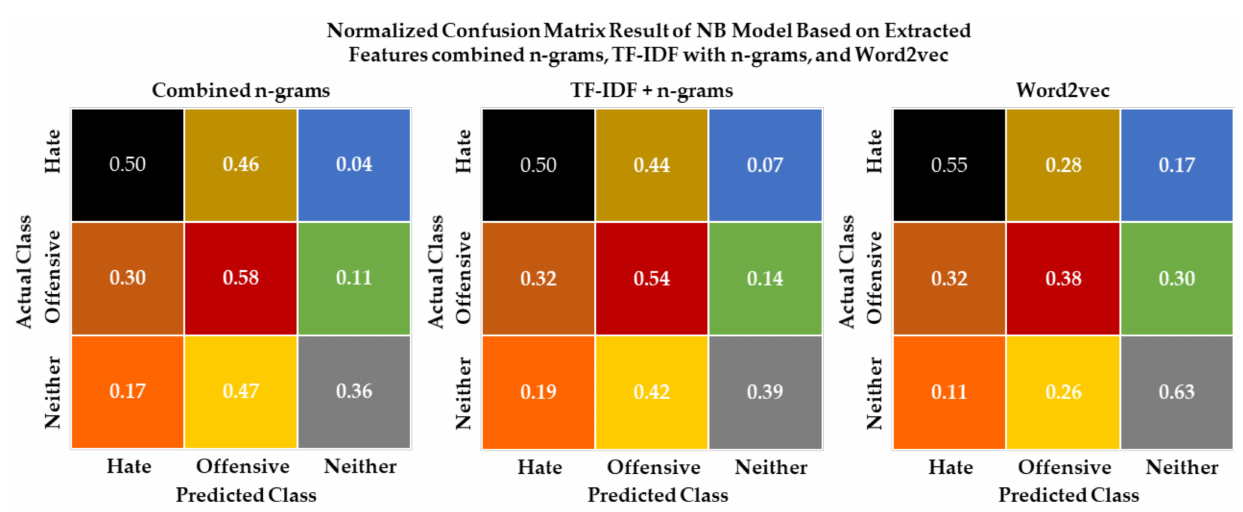
Figure 11. Confusion matrix of sample ternary NB models based on extracted features.